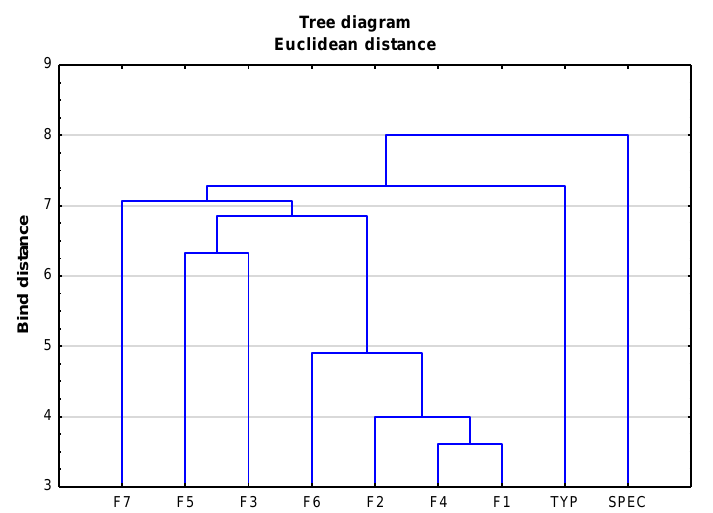
Figure 8. Dendrogram for supply chains of function execution.